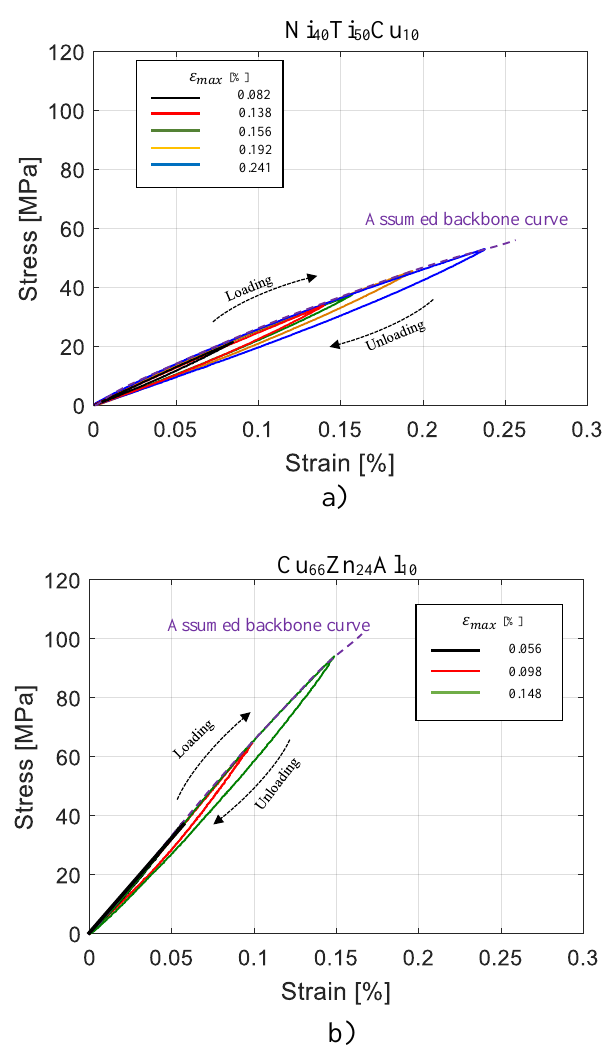
Figure 3. Nonlinear stress–strain behaviour of the materials investigated at different strain amplitudes: ( a ) NiTiCu, ( b )